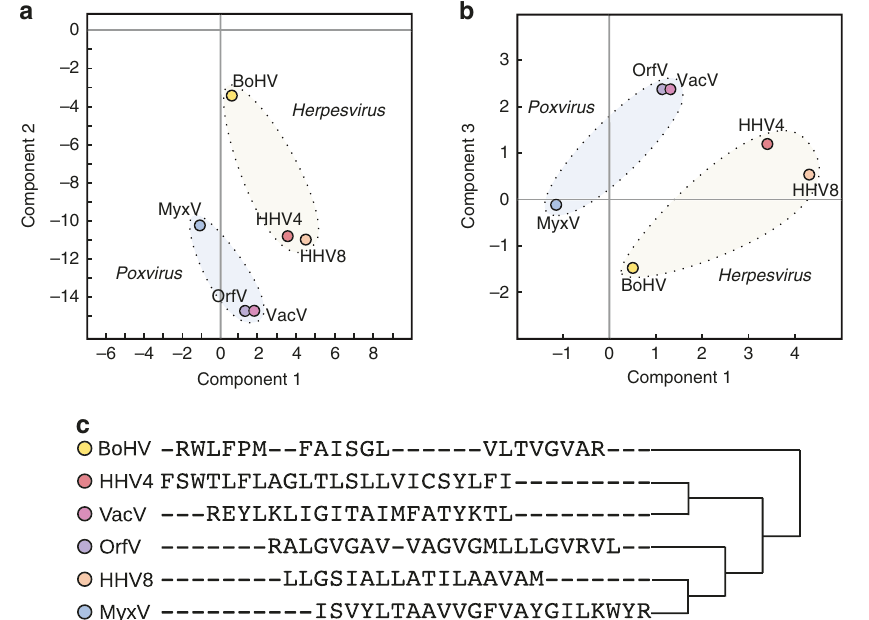
Fig. 6 TMD interaction and sequence pro fi le. a , b Principal component analysis (PCA) of vBcl2 TMDs interaction pro fi le with host TMDs. The colored areas highlight the viral families, with poxviruses in light blue and herpesviruses in light yellow. The analysis was performed using only the BiFC assay results. c vBcl2 TMDs Multiple Sequence Alignment. Results obtained with Clustal Omega (EMBL-EBI) using the default